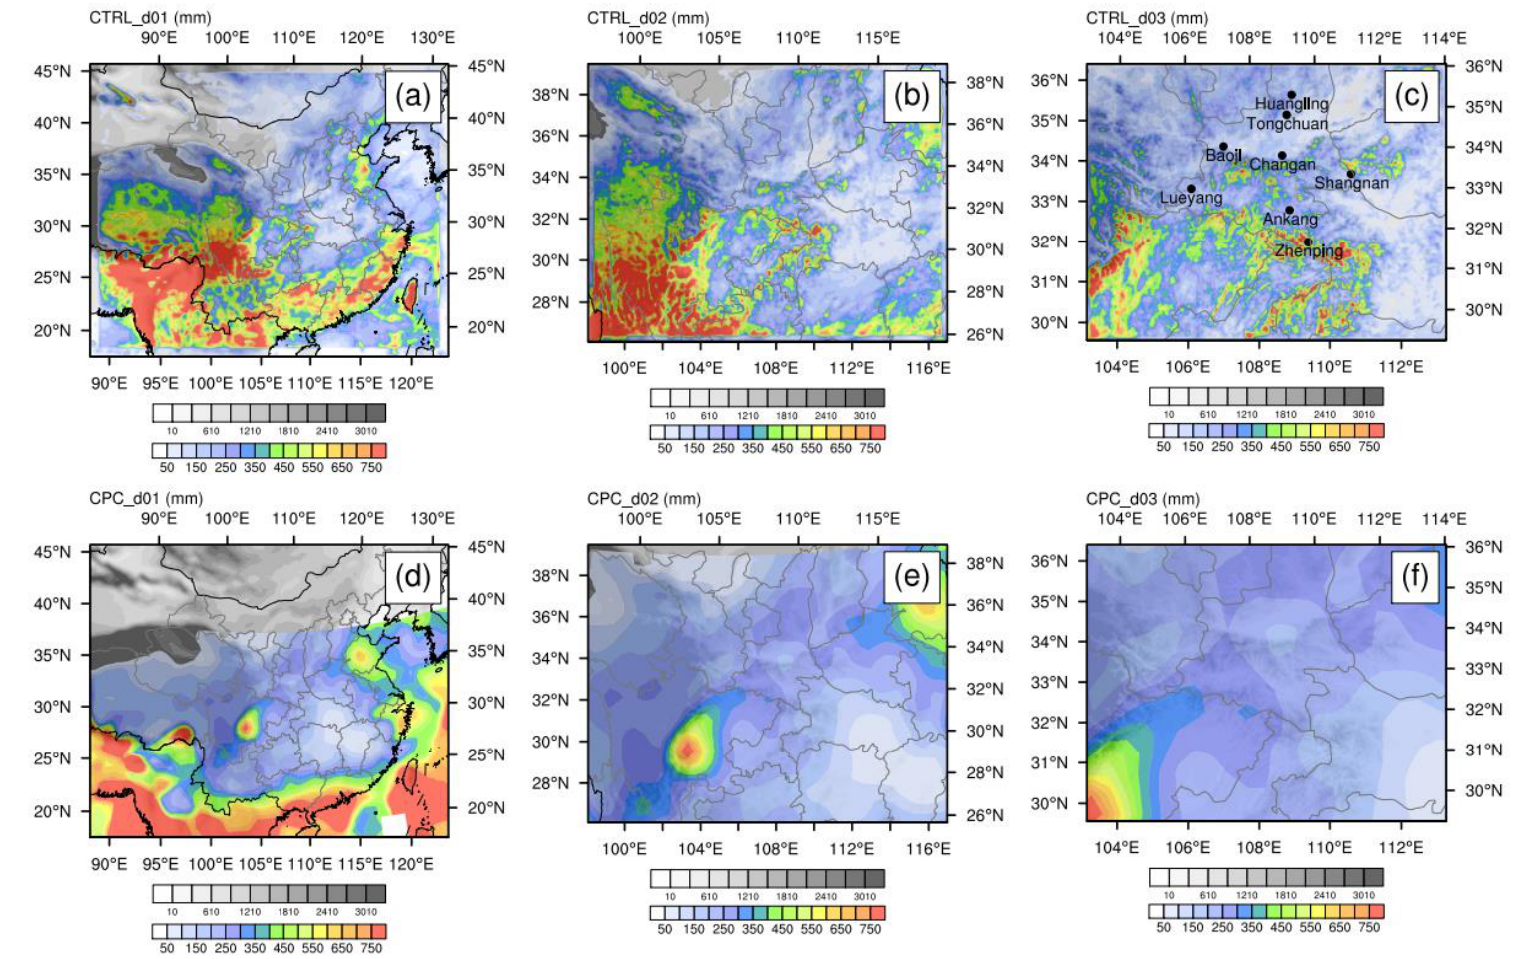
Figure 2. Comparison of accumulated precipitation (color-filled, in mm) in July and August in 2019 between CTRL simulation ( a – c ) and monthly analyzed precipitation ( d – f ) from the Climate Prediction Center (CPC) for domain 1 ( a , d ), domain 2 ( b , e ), and domain 3 ( c , f ) in Figure 1a. The altitude of the orography (in m) is in grey-filled. The black dots indicate the location of the 8 meteorological stations shown in Figures 3 and 4.